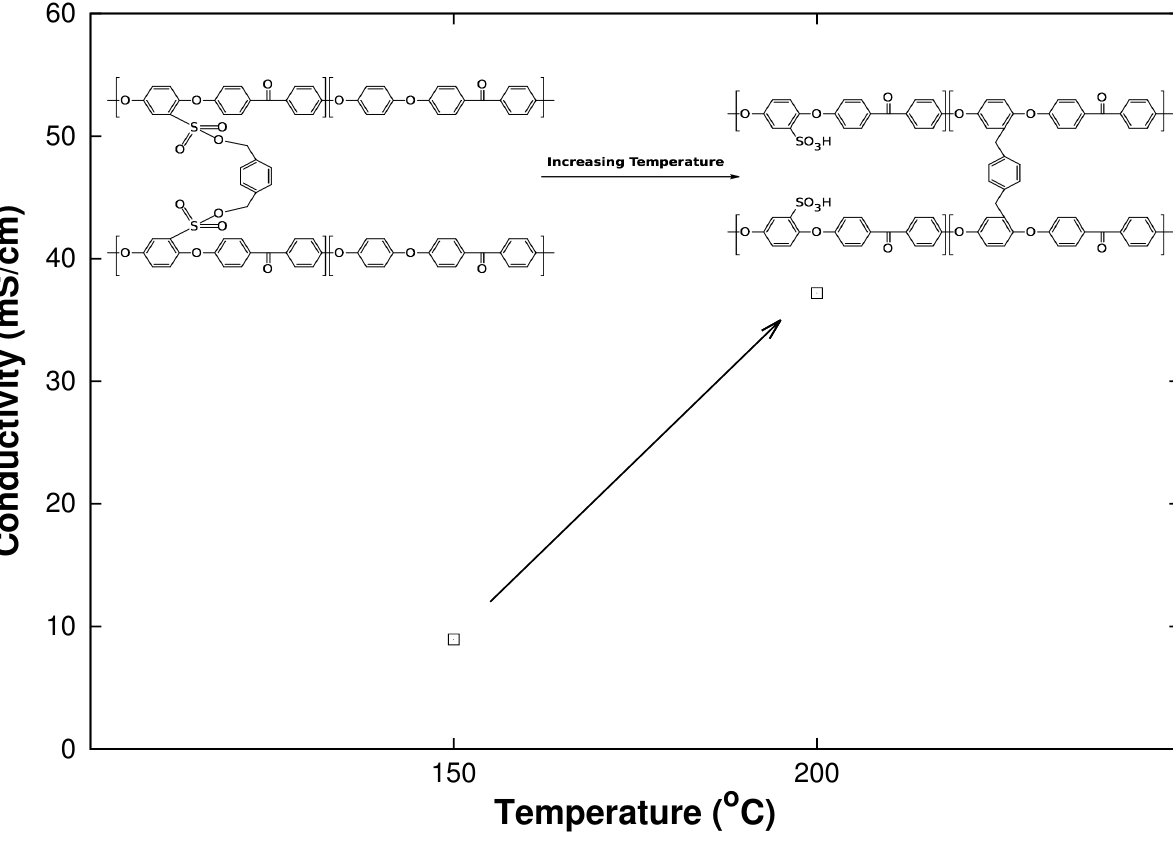
Figure 12. Dependency of crosslinking temperature and proton conductivity on one SPEEK membrane sample for a cSPEEK membrane with a SPEEK:crosslinker ratio of 3:1.